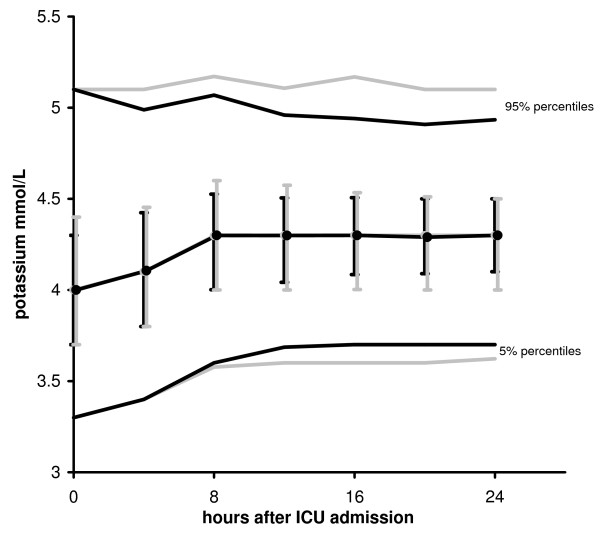
Time course of potassium. Time course of medians with 25- and 75-percentiles (i.e. interquartile ranges, indicated by error bars) and 5- and 95-percentiles of potassium during the first ICU day. The grey lines reflect the situation before and the black lines reflect the situation after GRIP-II. With preservation of the same median potassium levels, GRIP-II achieved a lower number of potassium levels that were out of range (P < 0.001).